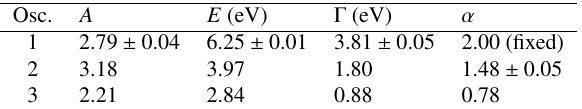
Table 1. Amplitude, energy, broadening, and energy dependend broadening parameter of Lorentz oscillators for bulk gold, obtained using equation (1) and equation (2) fitted over the experimental data in [14]. Moreover, E P = 8 . 78 ± 0 . 02eV and E T B = 0 . 073 ± 0 . 005eV.